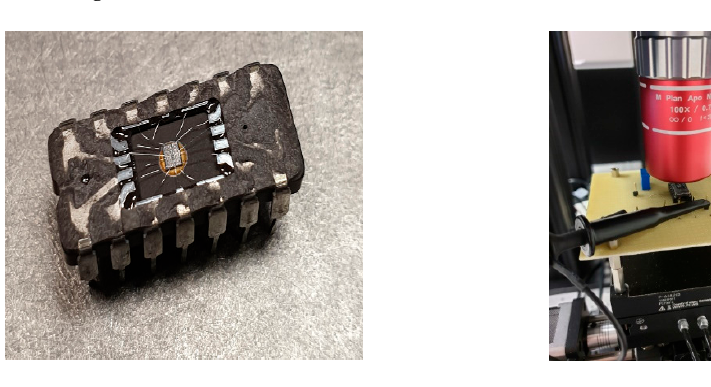
Figure 3. Device under test, the LM124 operation amplifier.